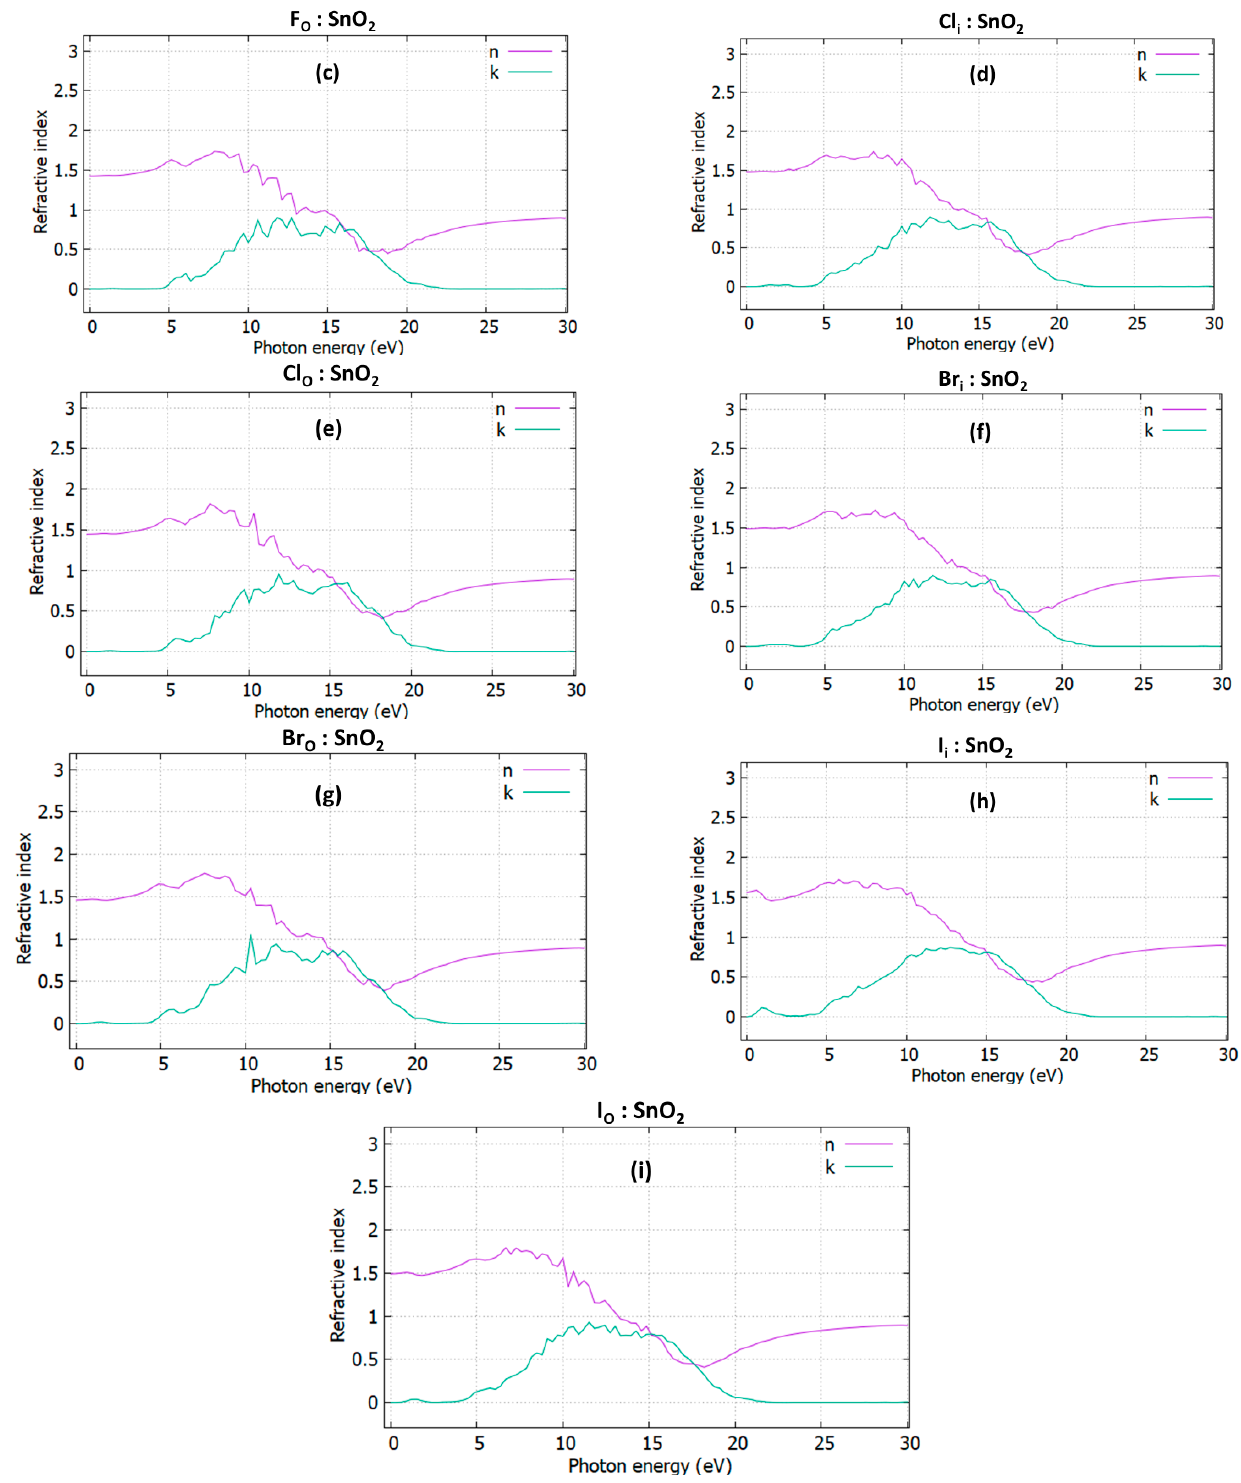
Figure 6. The refractive index of the ( a ) plain SnO 2 , ( b ) F i doped SnO 2 , ( c ) F o doped SnO 2 , ( d ) Cl i doped SnO 2 , ( e ) Clo doped SnO 2 , ( f ) Bri doped SnO 2 , ( g ) Br O doped SnO 2 , ( h ) I i doped SnO 2 , and ( i ) I O doped SnO 2 .